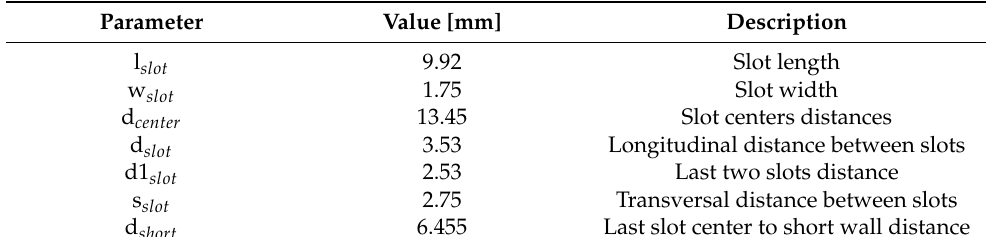
Table 1. Slotted waveguide antenna main design parameters.